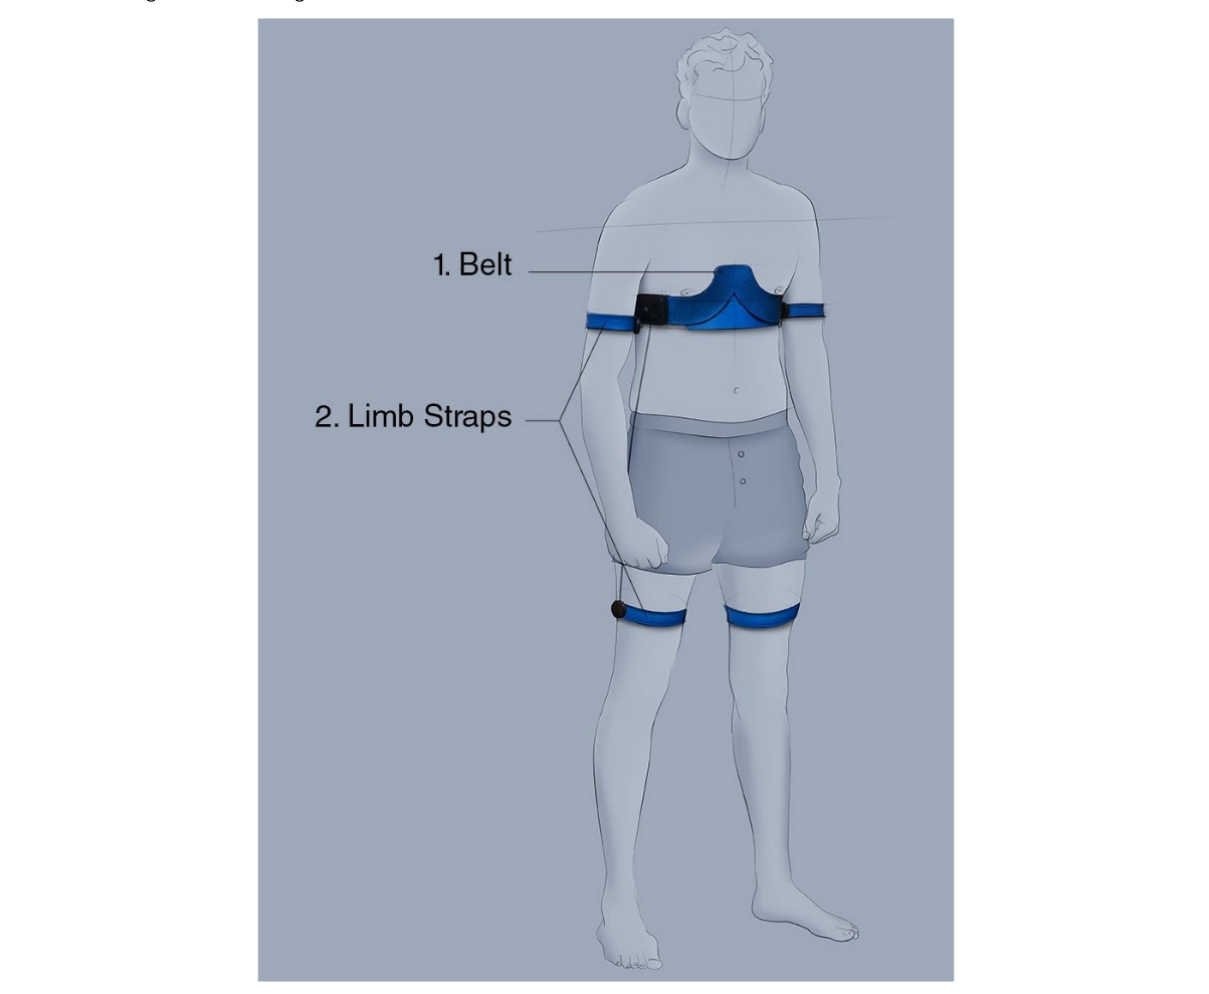
Figure 5. Positioning of the final design.